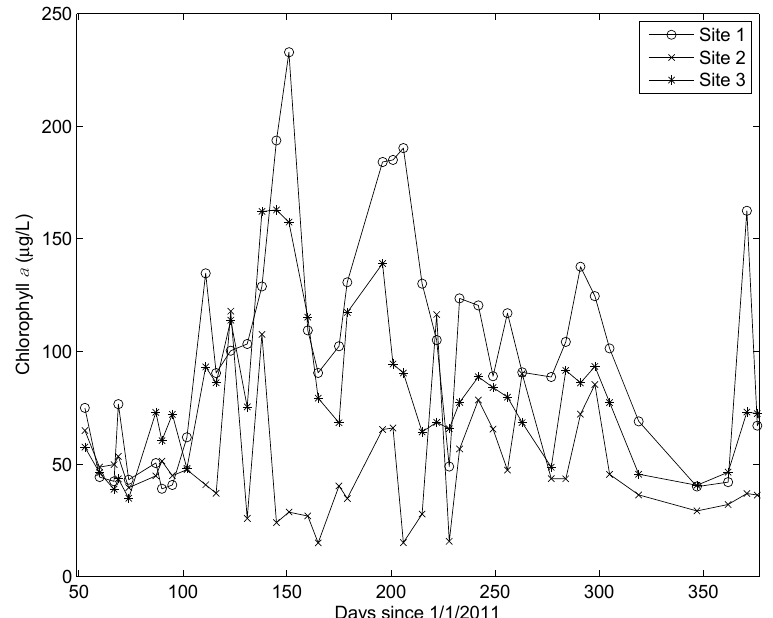
Figure 3. Time series of the chl a concentrations at the three sites. A Kruskal–Wallis test indicated that the concentrations at the three sites were different at p < 3 × 10 − 9 .